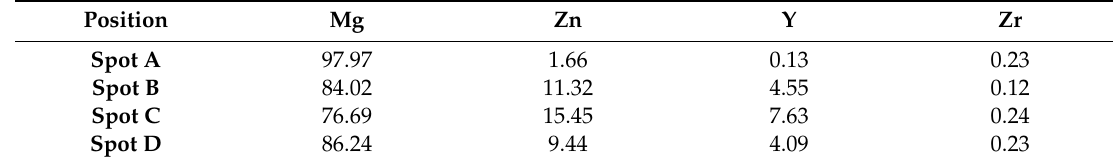
Table 9. Atom ratios (at%) for di ff erent elements of each spot in Figure 16b.